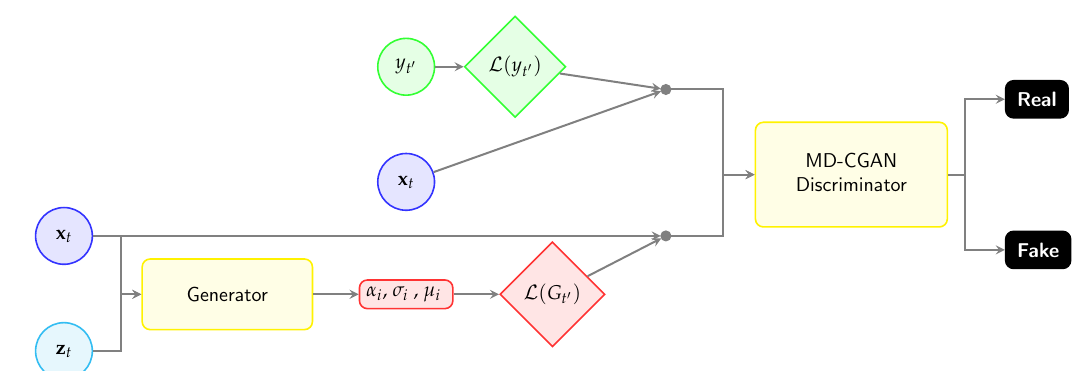
Figure 2. Schematic of the MD-CGAN model. We note that the discriminator in the MD-CGAN model has a different loss function and structure to the GAN and CGAN